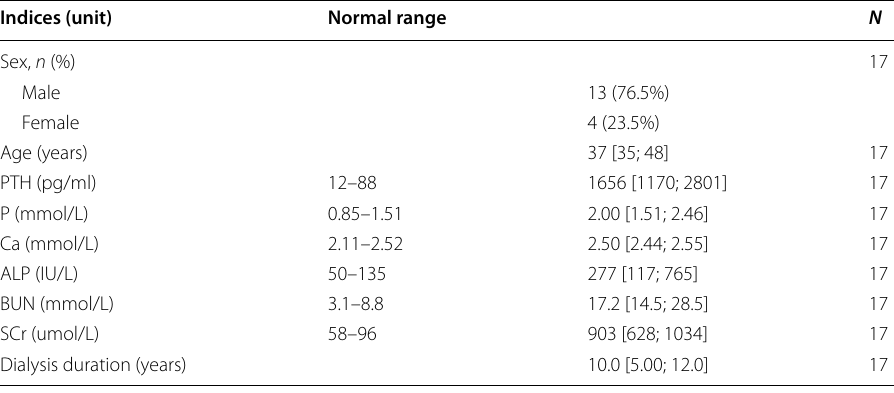
Data are represented as median [interquartile range] PTH parathyroid hormone, P phosphorus, Ca calcium, ALP alkaline phosphatase, BUN blood urea nitrogen, Scr